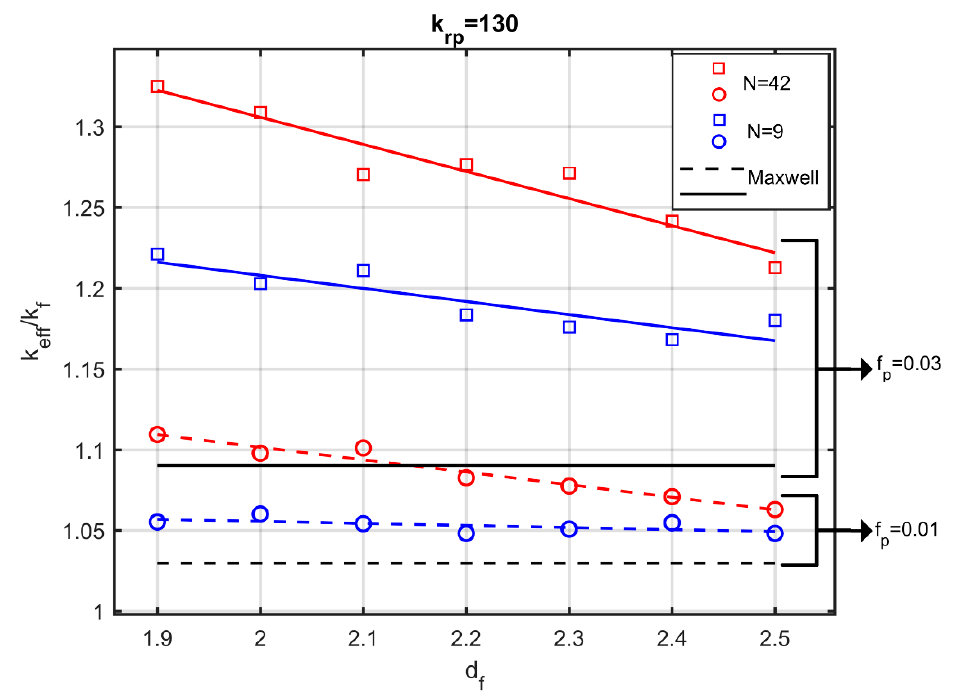
Figure 9. E ff ective thermal conductivity as a function of fractal dimension. Solid lines: f p = 0.03. Dashed lines: f p = 0.01. Blue lines: 9 particles per aggregate. Red lines: 42 particles per aggregate. Black lines: Maxwell’s model.